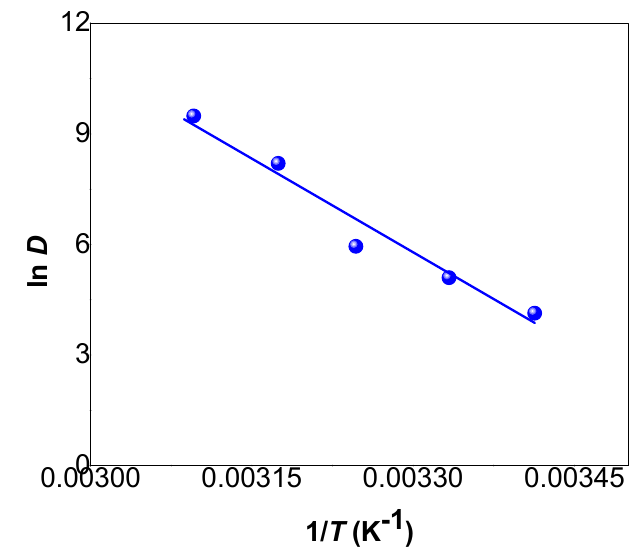
Figure 11. Plot of ln D vs. 1/ T for the MB dye removed from an aqueous solution by SNCM.